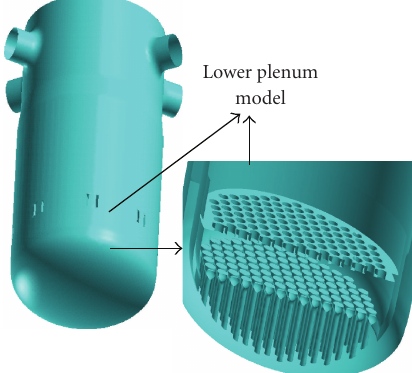
Figure 12: Detailed CFX-5 model of the downcomer and upper plenum of the